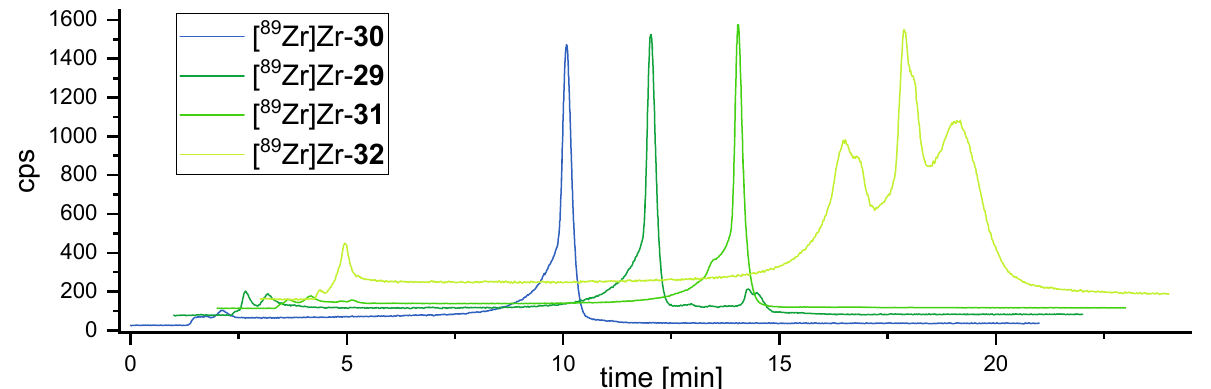
Figure 3. Analytical radio-HPLC chromatograms of the reaction mixtures of [ 89 Zr]Zr- 29 –[ 89 Zr]Zr- 32 .